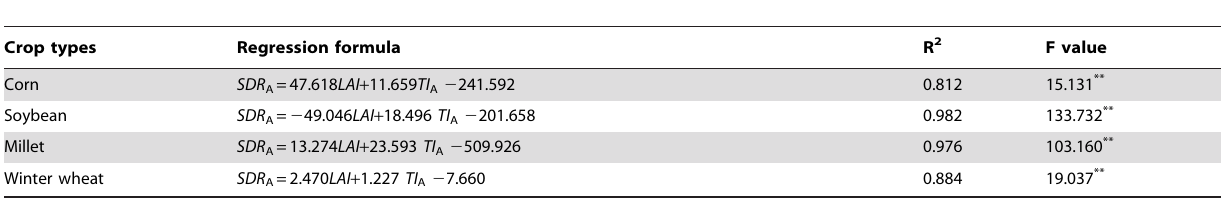
Table 3. Regression about the average splash detachment rate under crop